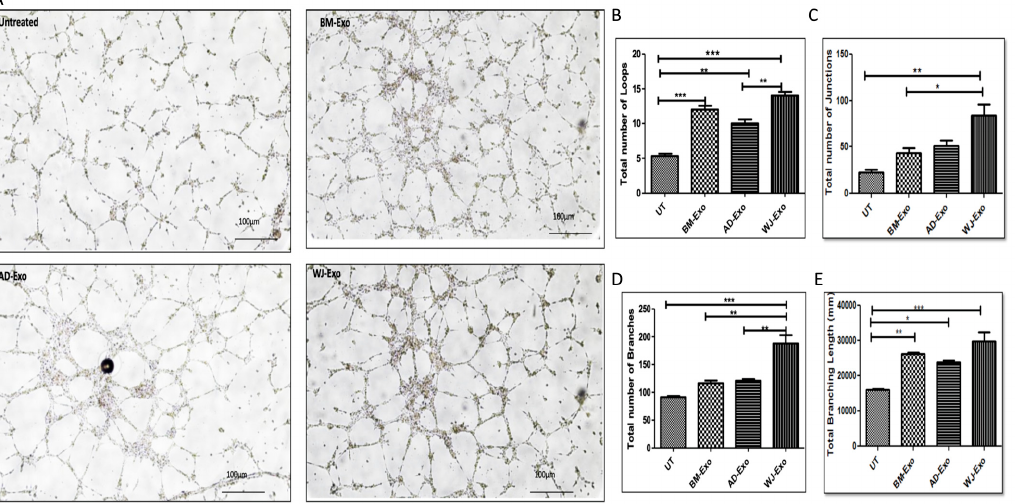
Figure 7. Human MSCs ‐ derived exosomes enhance tube formation in HUVEC cells. ( A ) Formation of tube ‐ like structure observed under a bright microscope: bar = 100 μ m; Magnification = 4×. Bar graph representing ( B ) the total number of loops, ( C ) a total number of junctions, ( D ) a total number of branches, and ( E ) total branching length (in mm). WJ–Exo showed a significant increase in the tube formation by HUVEC cells in respect to untreated. Data are represented as mean ± SD, * p < 0.033, ** p < 0.002, and *** p < 0.001.